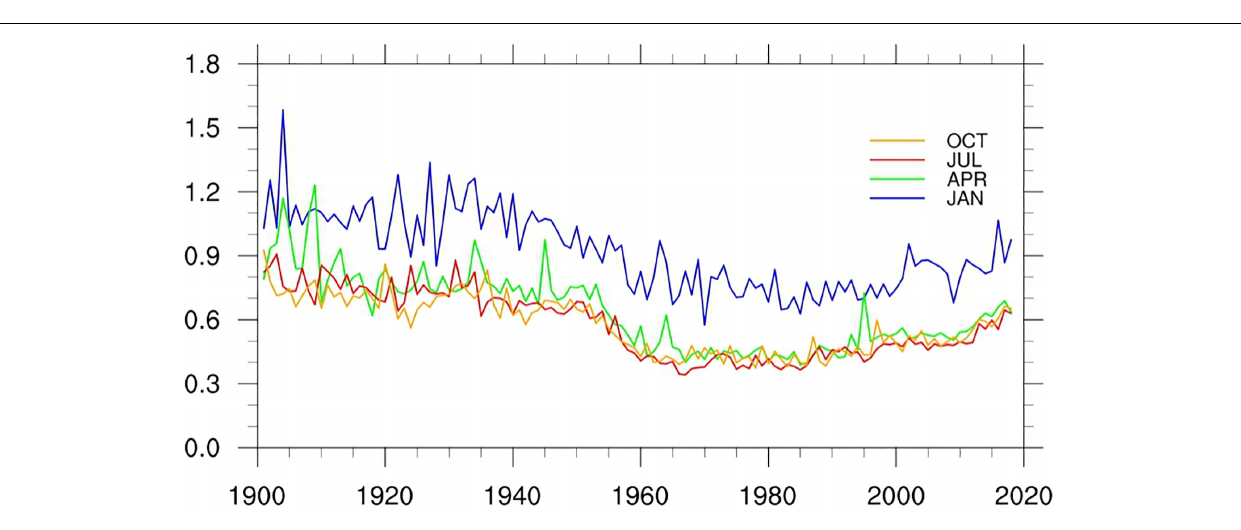
Frontiers in Environmental Science |